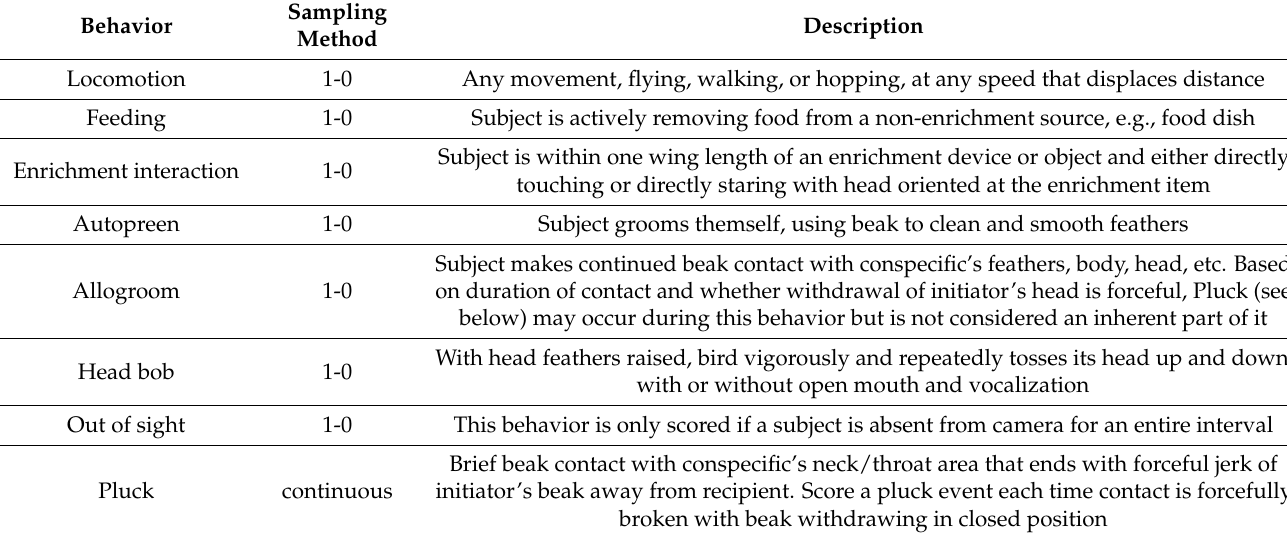
Table 4. Ethogram of behaviors sampled in Bali